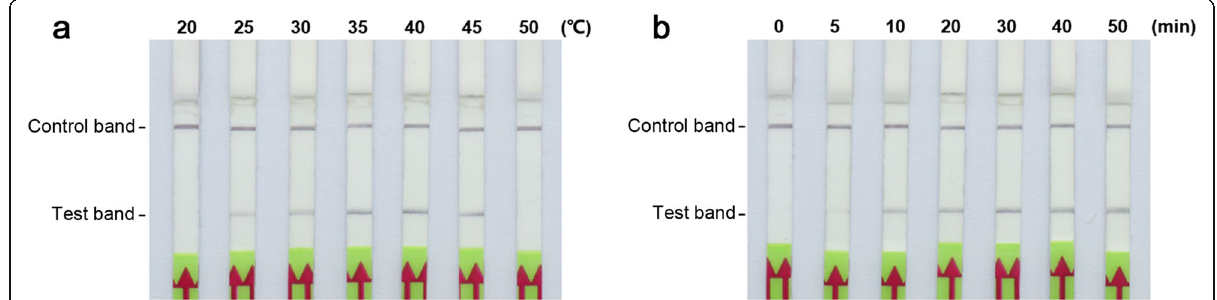
Fig. 1 Optimization of a lateral flow recombinase polymerase amplification (LF-RPA) assay for the detection of Phytophthora cactorum . a Optimization of the RPA amplification temperature (top). b Evaluation of the RPA reaction time